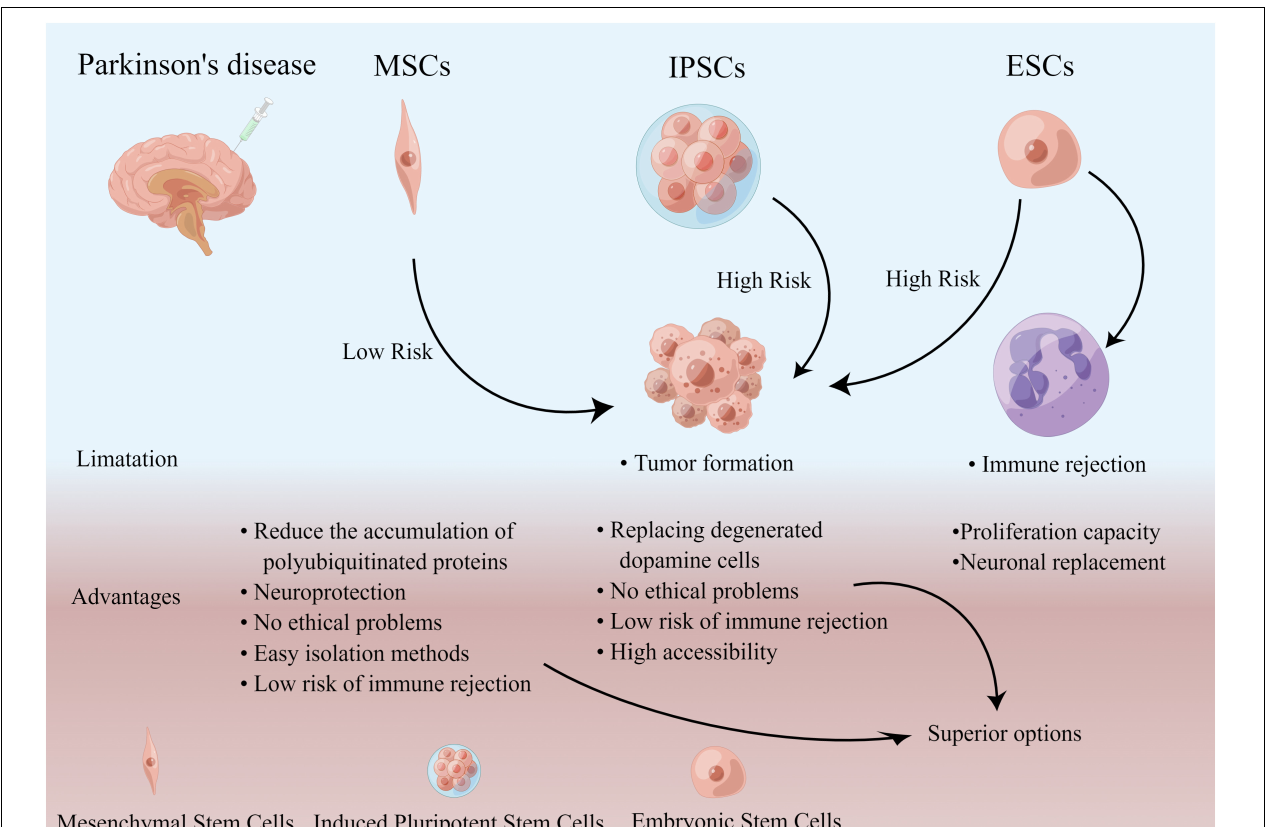
FIGURE 4 | Flow chart of a comparison of the limitation and advantages of